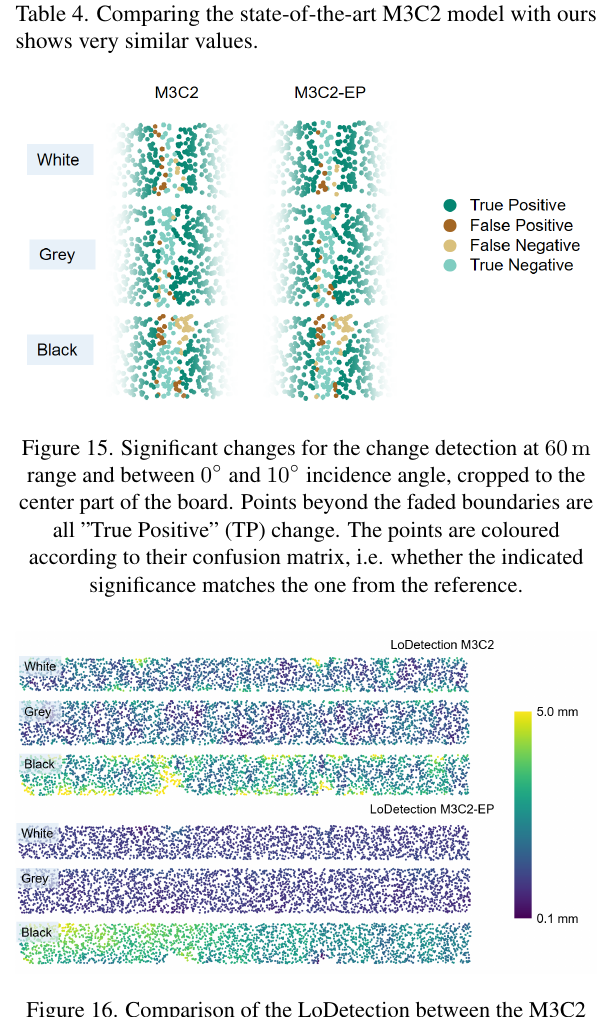
Figure 16. Comparison of the LoDetection between the M3C2 method and our method stemming from error propagation using the estimated model for the ranging precision (M3C2-EP). While our model shows a generally lower LoDetection, it is slightly higher than the baseline on the black surface material. The baseline method suffers from effects of locally lower point densities especially at the edges and close to data gaps.